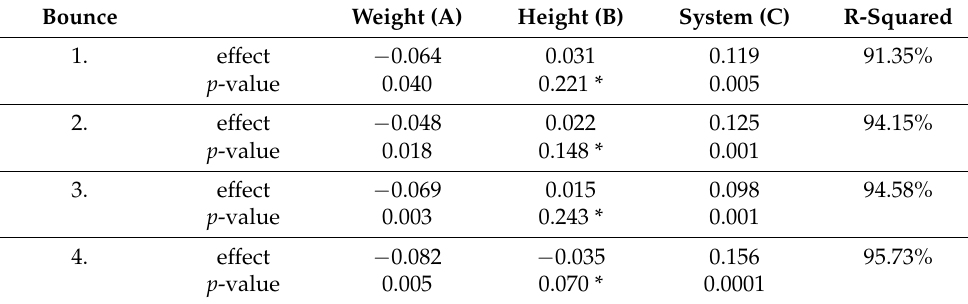
Table 4. Effects of main